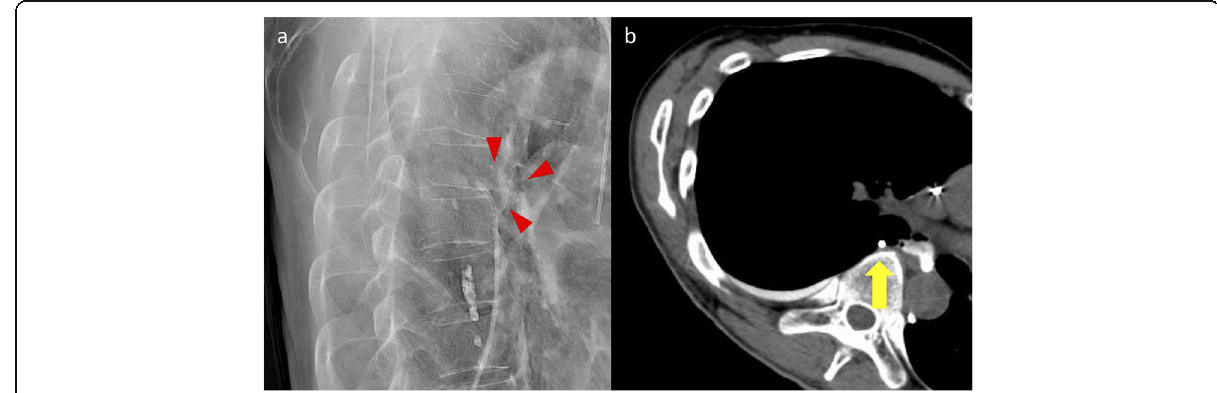
Fig. 4 a , b Pleurodesis with OK-432 through interventional radiology (IVR) from the leakage